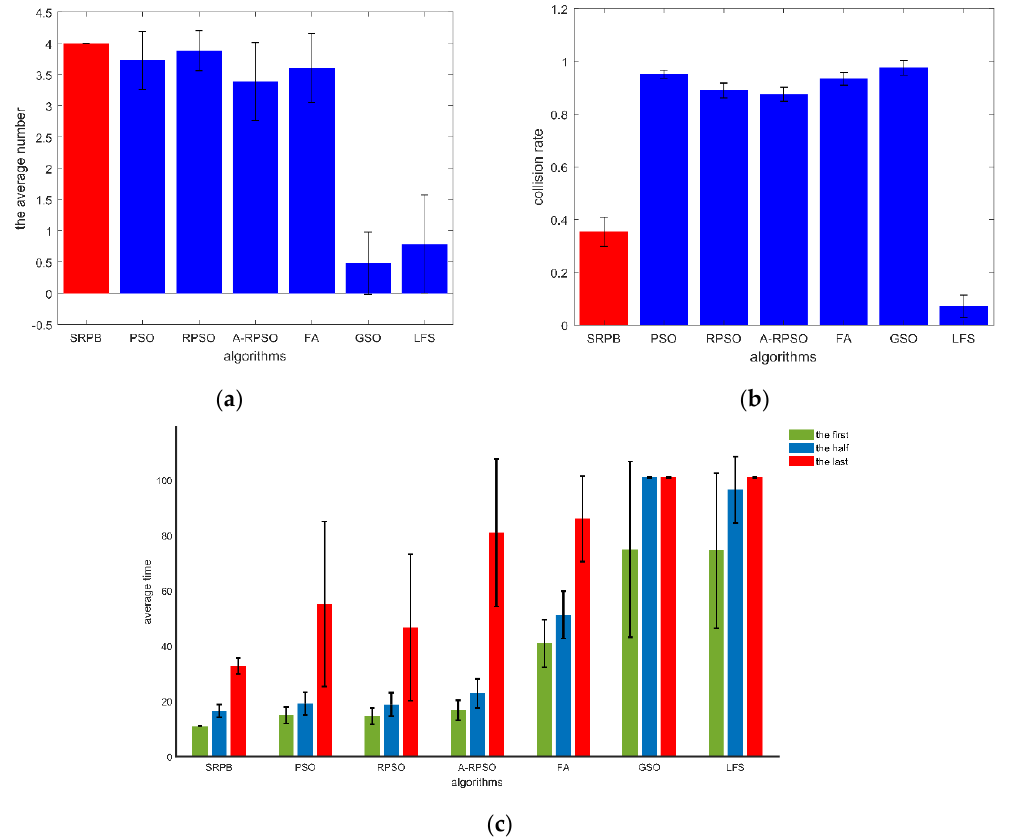
Figure 9. The performance of different strategies with the same initial position of robots in 100 m × 100 m. ( a ) the number of located sources; ( b ) collision rate; ( c ) the time to find sources.